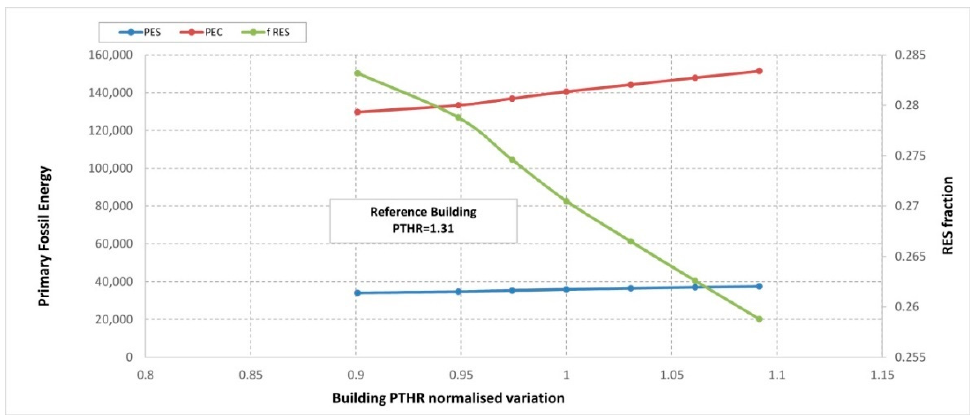
Figure 11. Performance indicator values with changes in building electrical loads.